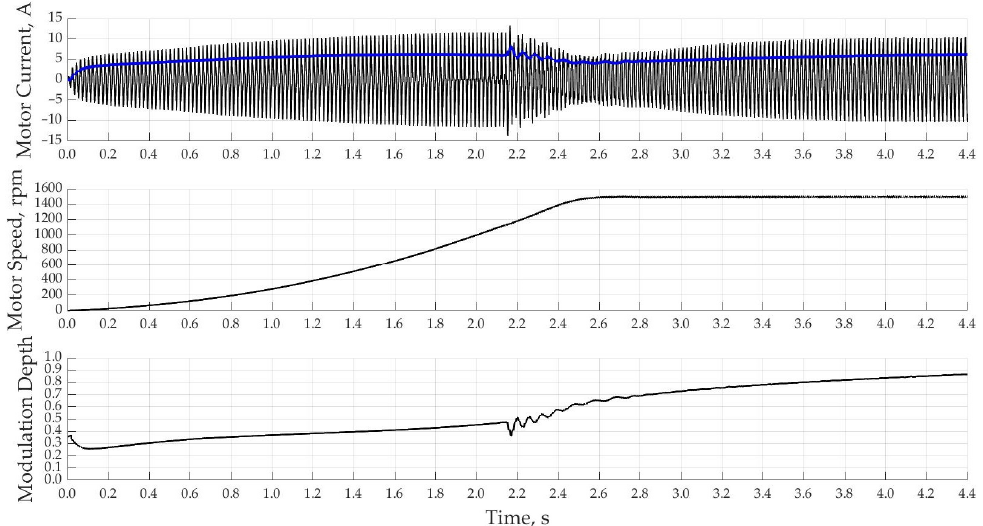
Figure 13. Starting current, motor speed and modulation depth under the PI-controller with single- loop CS of IM current with rated current according to reference.